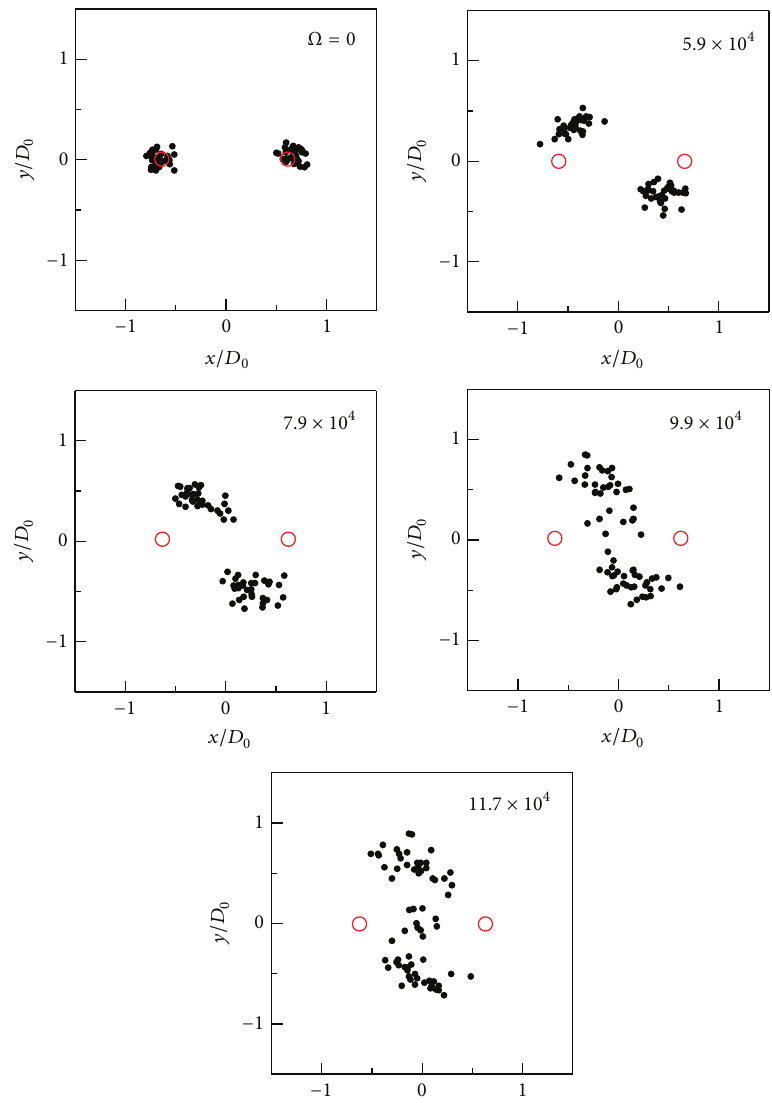
Figure 10: Bubble distribution over the horizontal section at 𝑧/𝐷 0 = 2.5 ( 𝑄 𝑔 = 24 mm 3 /s).